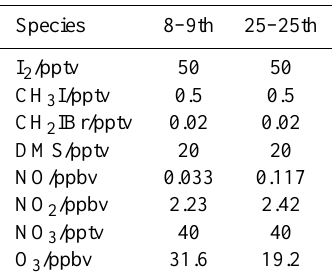
Table 1. Summary of parameters used by the model to simulate night-time IO observations.